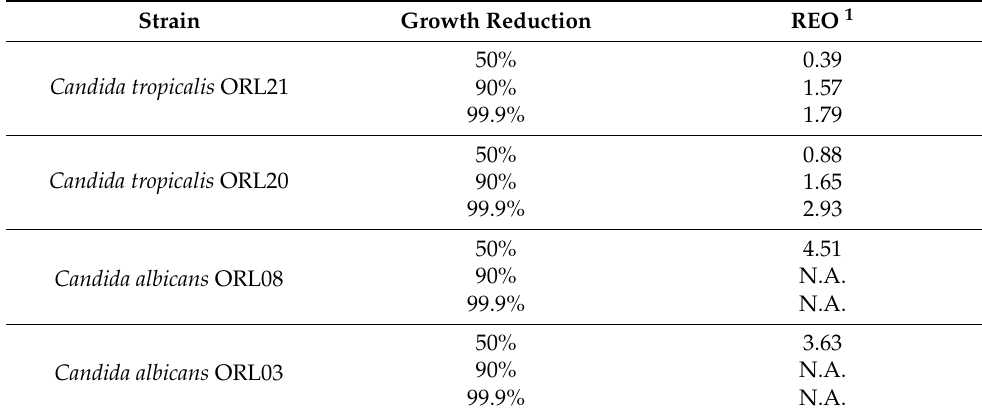
Table 4. Time for REO to reach 50%, 90%, and 99.9% growth reduction concerning start inoculum to C. tropicalis and C. albicans strains. Strain Growth Reduction Candida tropicalis ORL21